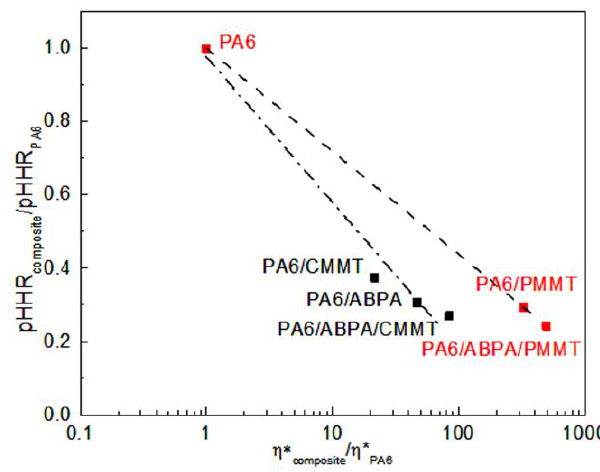
Figure 10. Variation of reduced pHRR as a function of increased viscosity at low frequency for PA6 and PA6 composites .